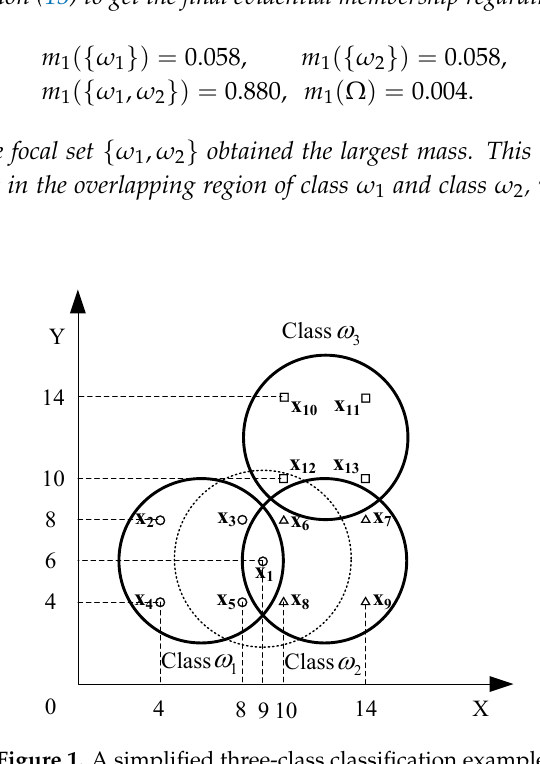
Figure 1. A simplified three-class classification